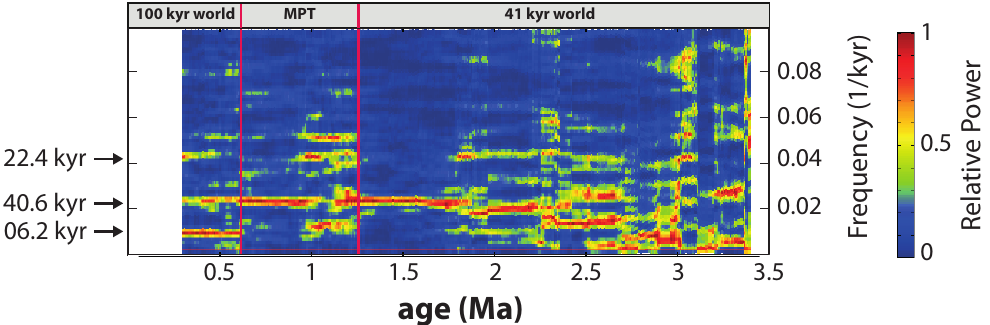
Figure 7. Evolutionary power spectrum of the Rb/Sr ratios from 305 to 3397ka, resulting from the chosen window width of 240ka (window type: boxcar). The software used, ESALAB (Weber et al., 2010), is based on the same algorithms as